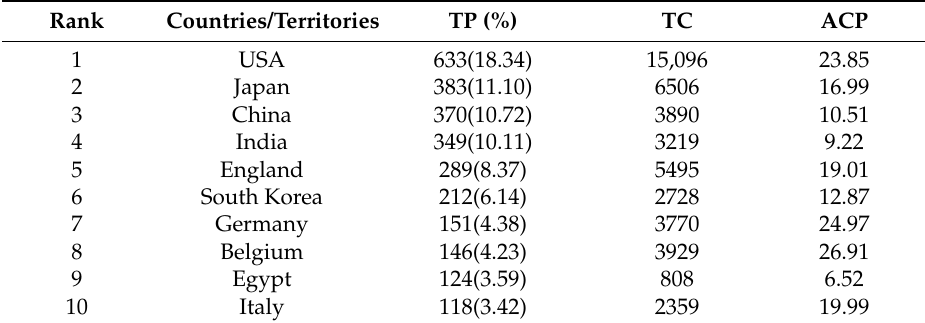
Table 1. Global publication shares of the top 10 most productive countries.